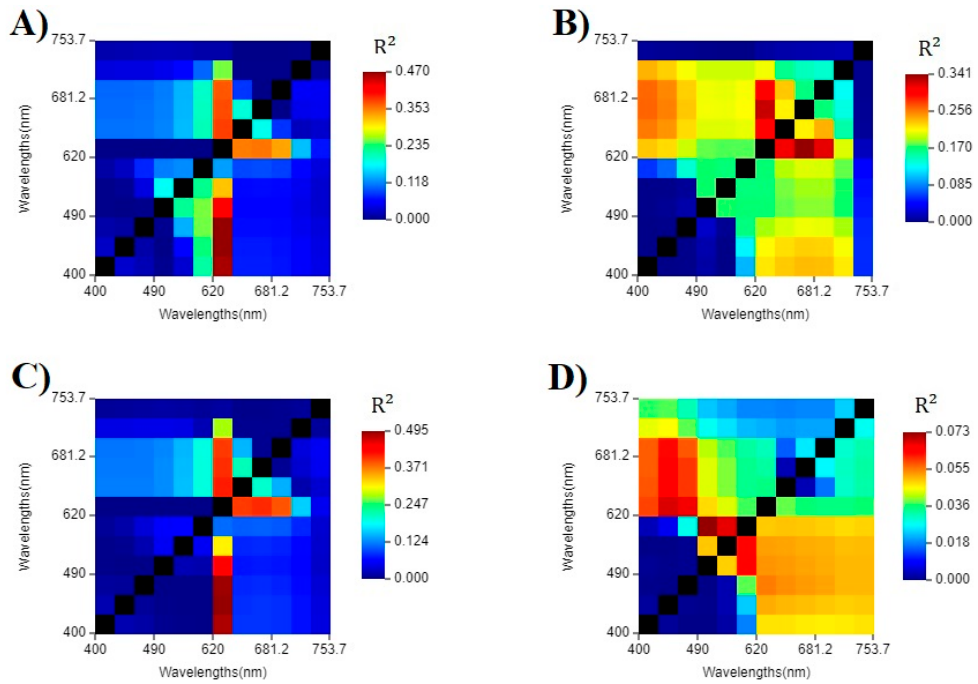
Figure 5. 2D color R 2 plots for chl- a concentration estimation ( A ) R 2 values for all data; ( B ) R 2 values for the day before the field sampling data; ( C ) R 2 values for same day of the field sampling data, and (D ) R 2 values for the day after the field sampling data.